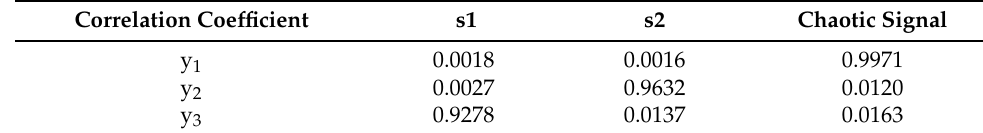
Table 1. Correlation coefficient between each separated signal and the source